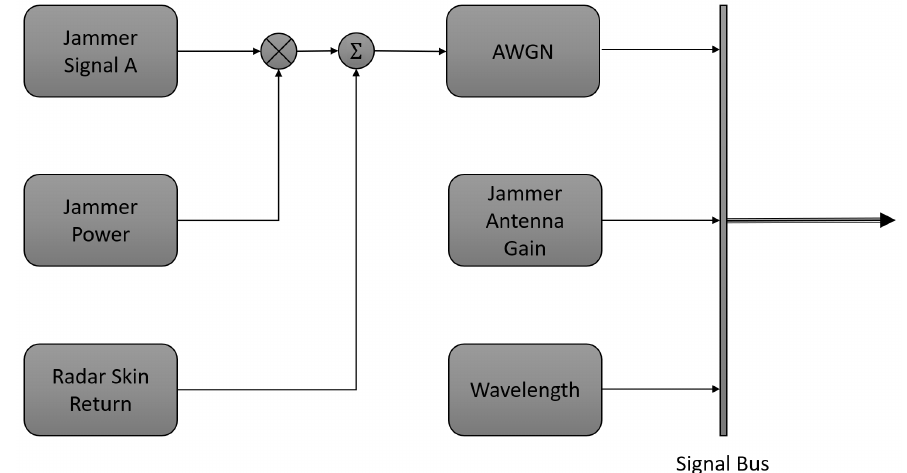
Figure 7. The system model for the formation jamming system, replicated for each of the two jammers. A set of user operated switches, embedded in the jammer signal subsystem, allowed for selection of the three possible jamming techniques.